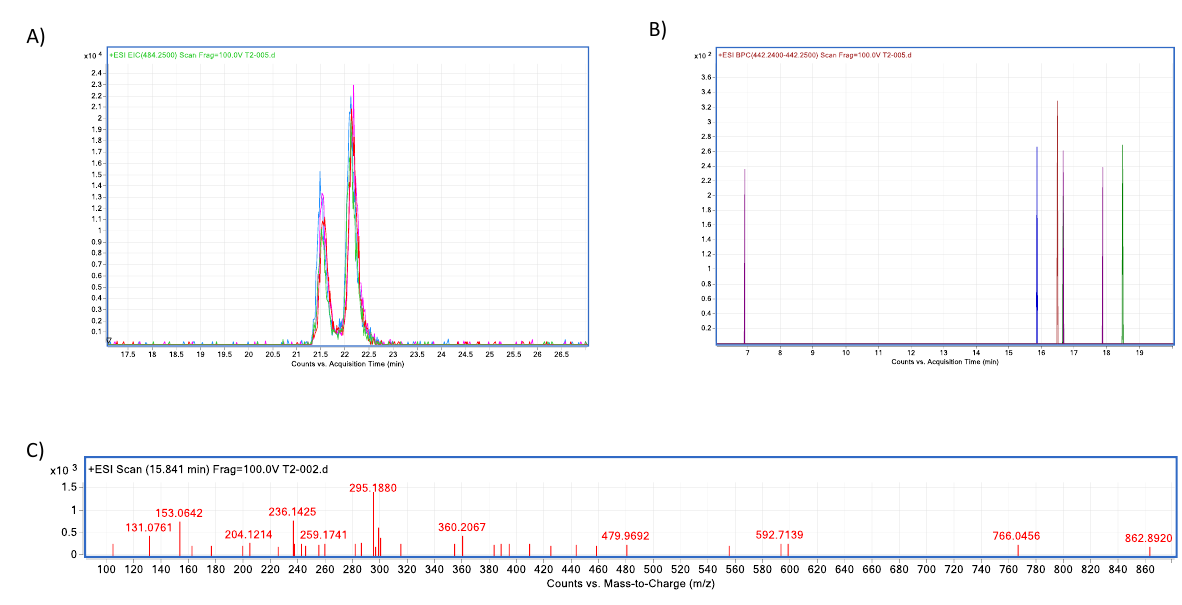
Figure 13. Trypsin–T2 biotransformation HPLC–TOF–MS chromatograms showing: ( A ) T-2 toxin control peak; ( B ) HT-2 molecular ion (M+1) final product of T-2 biotransformation by trypsin, as found in tested tubes; ( C ) T-2′ s molecular ion as found in control tubes (M + 1); ( D ). 2.5.2. OTA